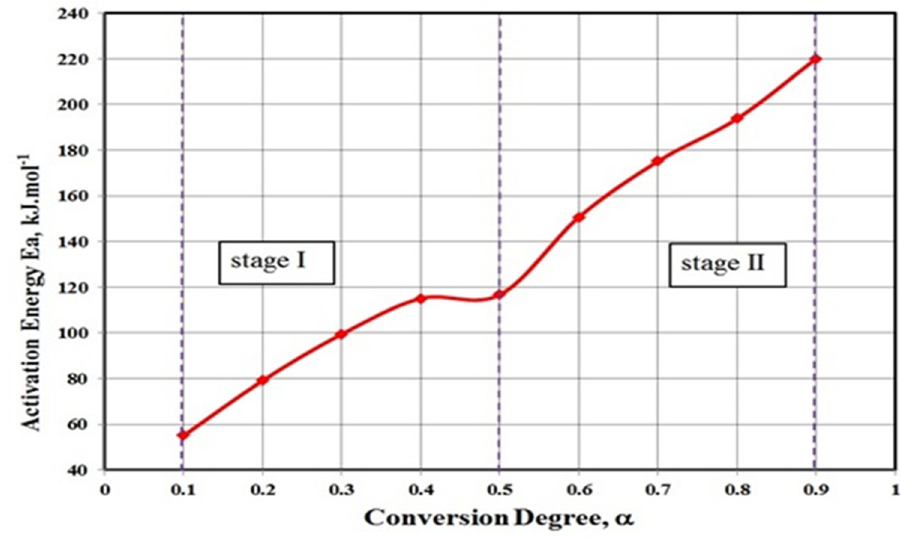
Figure 10. Calculated Ea against conversion degree for Fe 2 O 3 /coal.